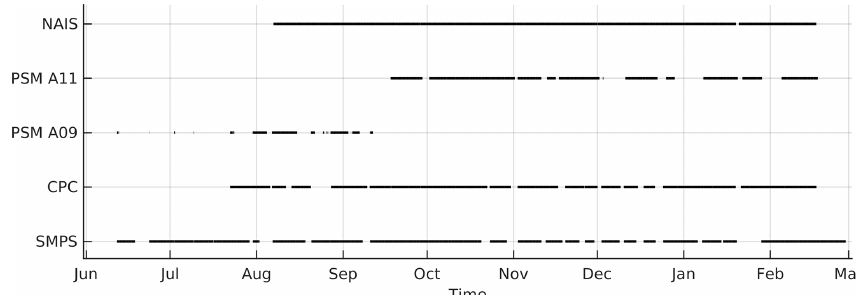
Figure 1. Black lines indicate when data are available for each instrument for the 2020–2021